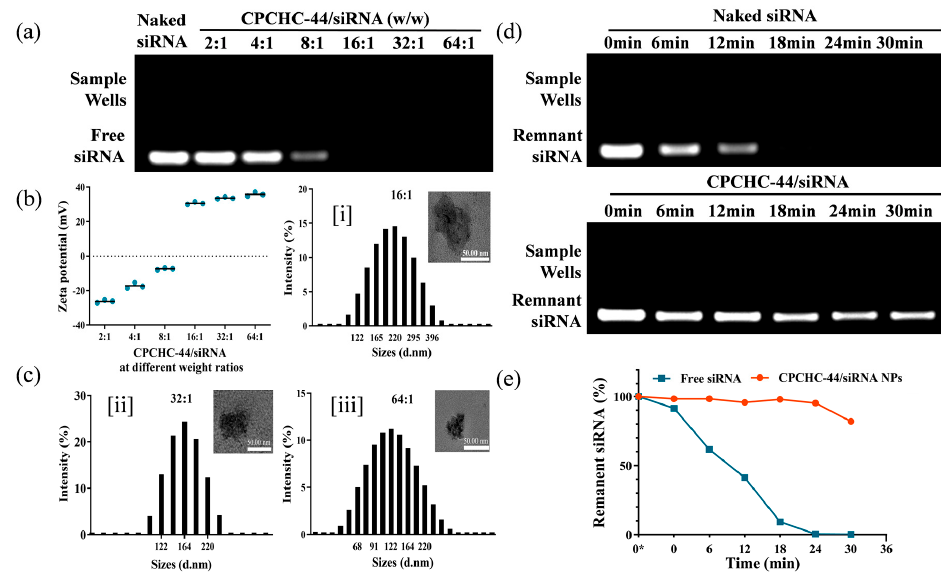
Figure 2. Characterization of CPCHC-44/siRNA NPs. ( a ) Electrophoretic mobility of CPCHC- 44/siRNA nanocomplexes at different weight ratios. The dose of siRNA was fixed at 0.125 µ g in each sample well. ( b ) Zeta potential for the nanoplexes at different CPCHC-44/siRNA weight ratios. ( c ) Particle sizes of CPCHC 44/siRNA nanocomplexes at CPCHC-44/siRNA weight ratio of 16:1[i], 32:1[ii], and 64:1[iii]. The inset indicates the TEM image of the corresponding CPCHC- 44/siRNA NPs, scale bar = 50 nm. ( d ) Agarose gel electrophoresis results of remanent siRNA. The degradation of naked siRNA and CPCHC-44/siRNA ( w / w = 16:1) after incubation with a RNase A-containing solution for a predetermined time to obtain the remnant siRNA. The fluorescence intensity corresponds to the remained siRNA amount was recorded on an agarose gel imaging system. ( e ) Quantification of remanent siRNA was performed through an ImageJ software. Results are presented as the mean ± SD, n =